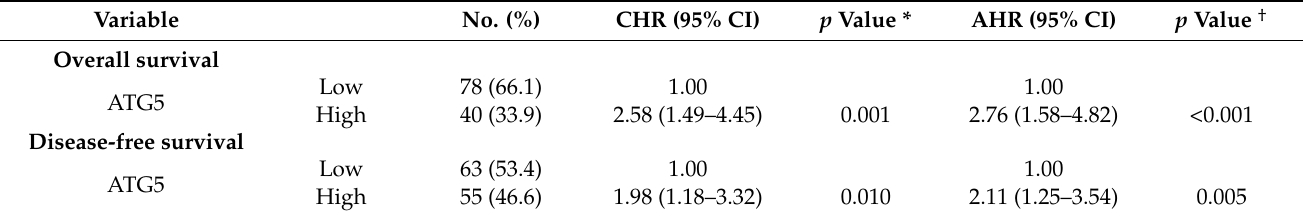
Table 1. Impact of ATG5 expression levels on survival of CRC patients.